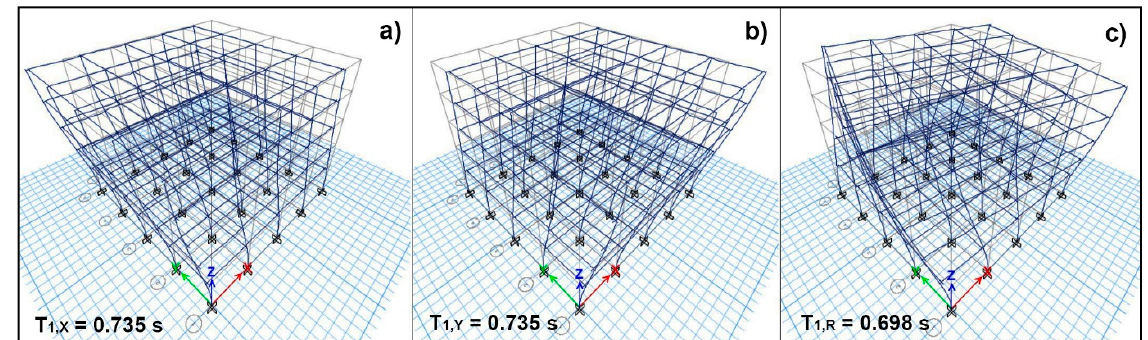
Figure 3. Fundamental periods of vibration of nonlinear model: ( a ) translational T 1 ,X ; ( b ) translational T 1 ,Y ; and ( c ) rotational T 1, R .